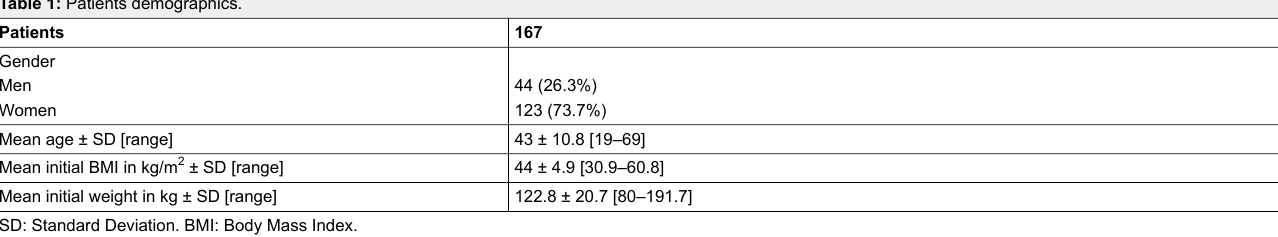
Table 2: Perioperative results.